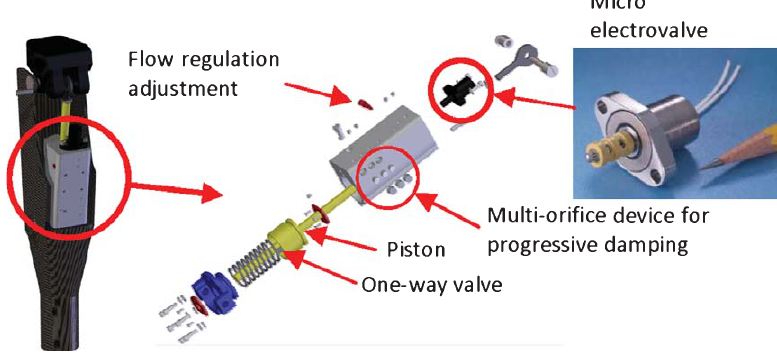
Fig. 3. Exploded view of the prosthetic